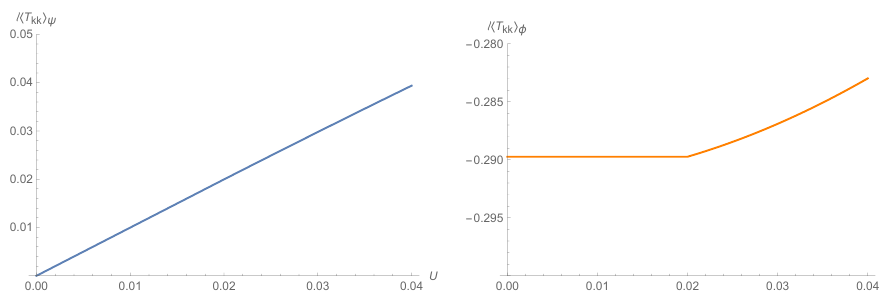
Figure 3 . Details of the interpolation between the origin and U = (cid:15) = 0 : 02 for the spinor and scalar in (cid:12)gure 2.